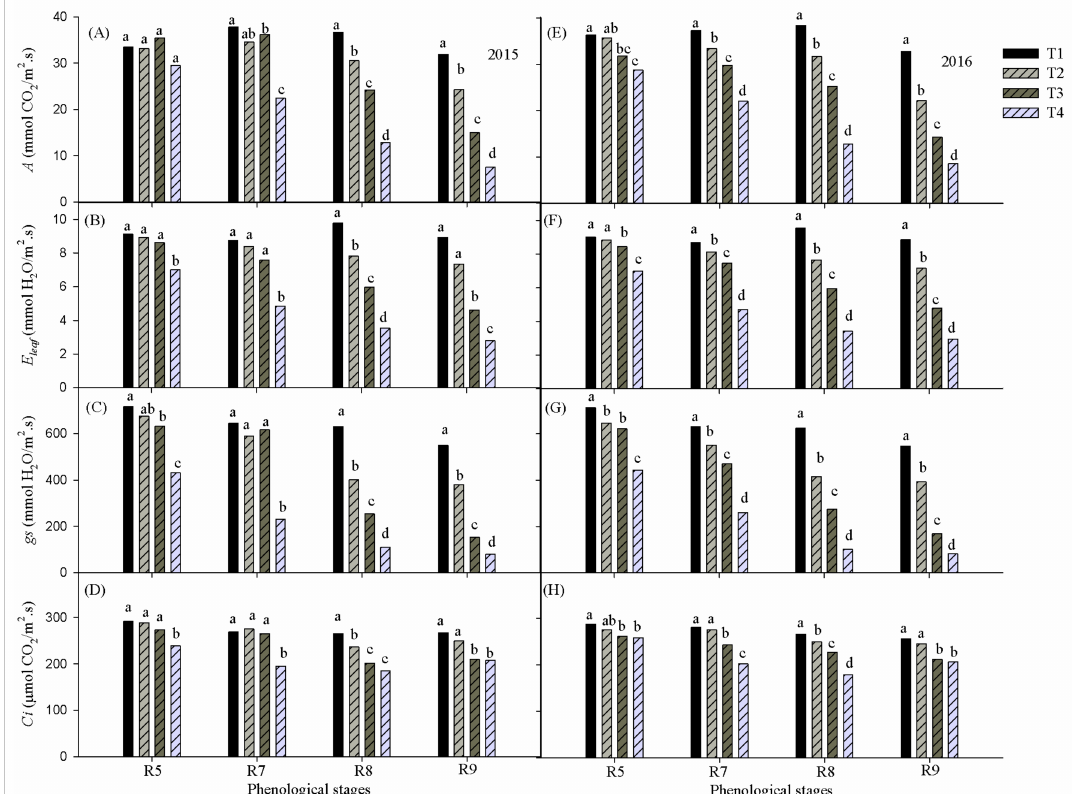
Figure 3. Net photosynthetic rate— A ( A ), Leaf transpiration— E leaf ( B ), Stomatal conductance— gs ( C ) and Substomatal CO 2 concentration— Ci ( D ) of cowpea plants in differents reproductive phase in response to accumulated soil water deficiency in the 2015 and 2016 ( E – H ) experiments, respectively. Means followed by the same letter do not differ statistically between treatments (Tukey teste, p ≤